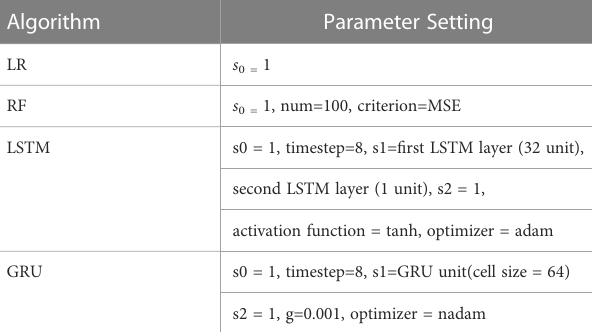
TABLE 3 Parameter settings of each comparison model. Algorithm